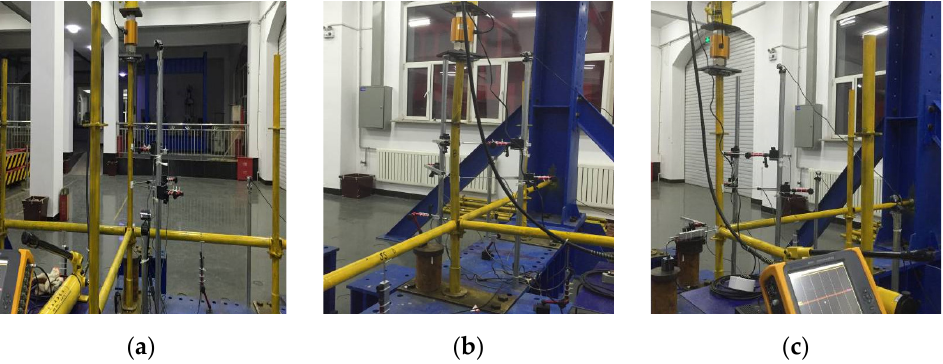
Figure 25. Failure modes of single-layer vertical poles: ( a ) Central pole; ( b ) side pole; ( c ) corner pole.